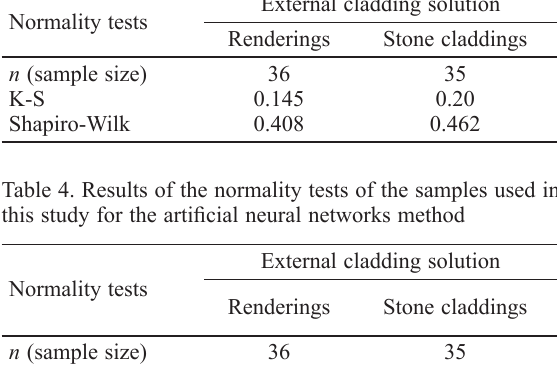
table 3. results of the normality tests of the samples used in this study for the artificial neural networks method Normality tests